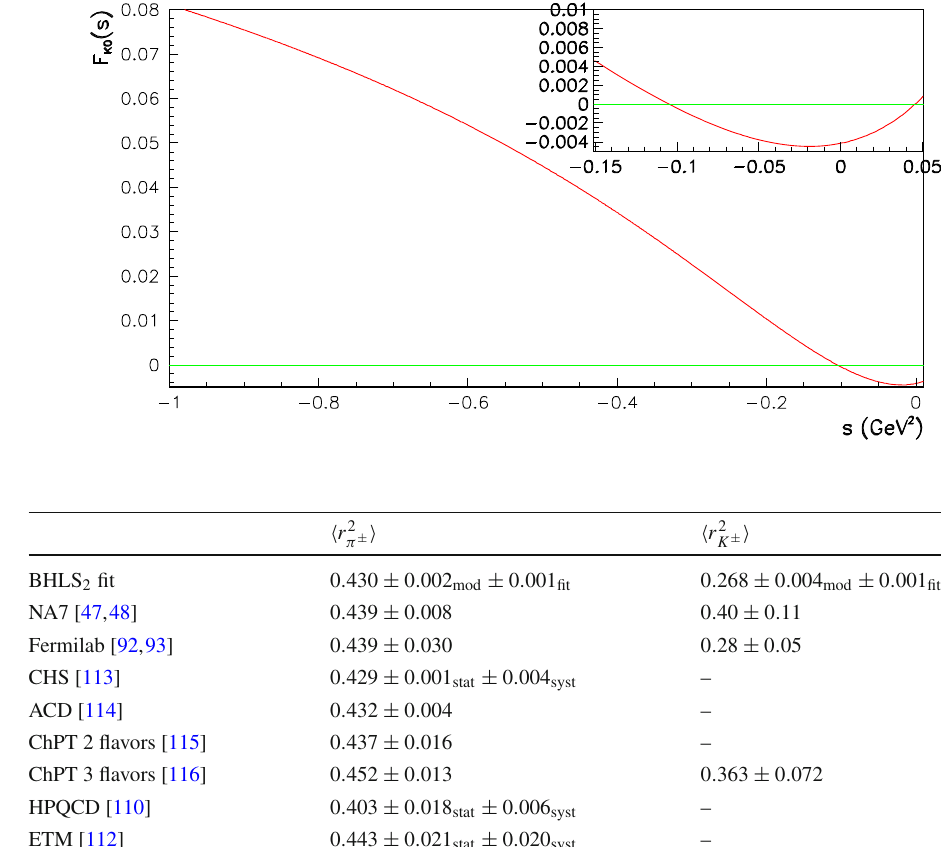
Table 5 Pion and kaon charged radii in units of fm 2 . See also [117] for additional LQCD evaluations of (cid:16) r 2 π ±